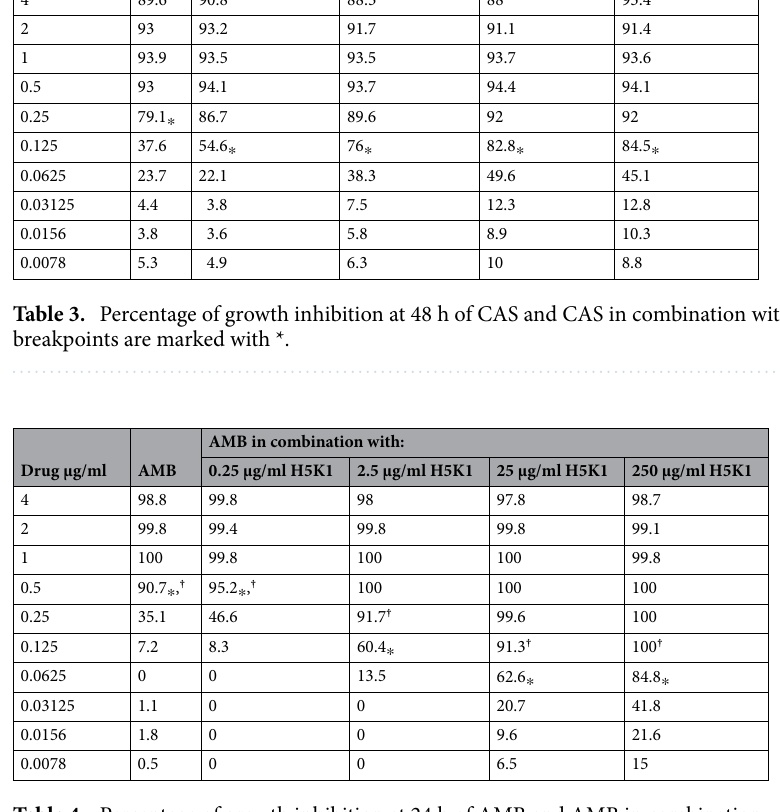
Table 4. Percentage of growth inhibition at 24 h of AMB and AMB in combination with H5K1. The MIC50 breakpoints are marked with *. The MIC90 breakpoint are marked with † .